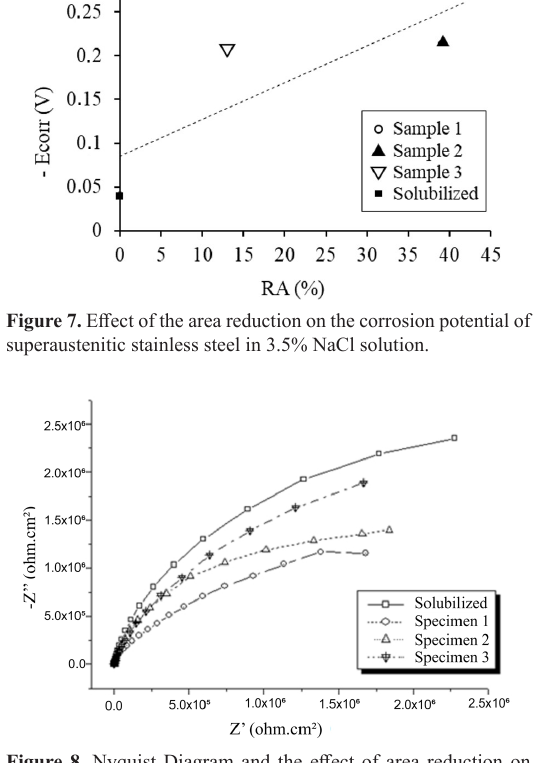
Figure 8. Nyquist Diagram and the effect of area reduction on the charge transfer resistance of the superaustenitic stainless steel (3.5% NaCl